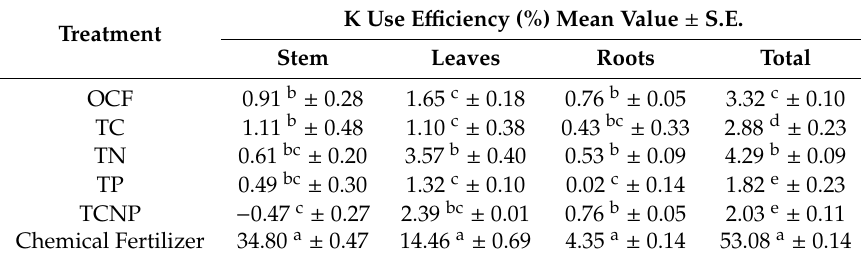
Table 7. E ff ect of treatments on potassium use e ffi ciency in maize plant parts.